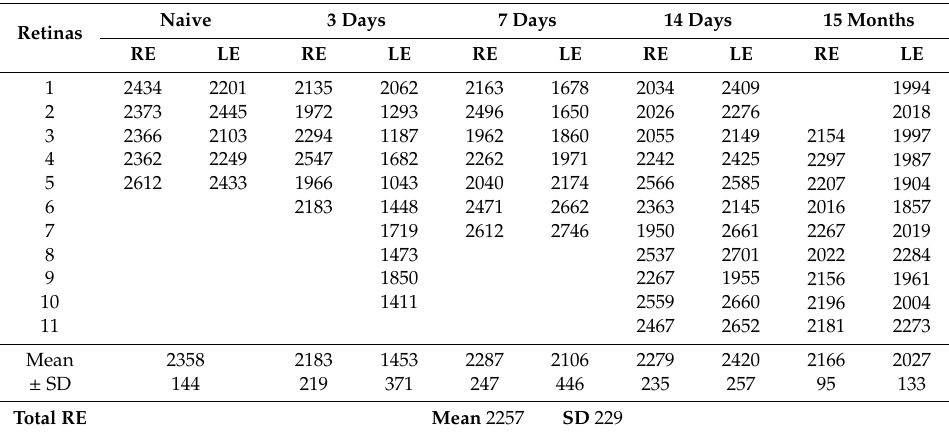
Figure 4. Bar graph showing the percent vs. intact retinas of the total number of m + RGCs ± standard deviation quantified in the contralateral uninjured and experimental retinas analyzed 3, 7, 14 days, or 15 months after the intraocular injection of 100 nM NMDA. The number of analyzed retinas is shown at the bottom of each bar. Note: * Significant differences compared to naïve, contralateral retinas, and other time points (Kruskal-Wallis test, p < 0.001); # the percent of m + RGCs in the experimental groups analyzed at 7 days, 14 days, or 15 months did not differ significantly from their contralateral fellow retinas (Mann-Whitney Test, p > 0.05). Table 2. Total numbers of m + RGCs in right (RE) or left (LE) eye retinas. Retinas